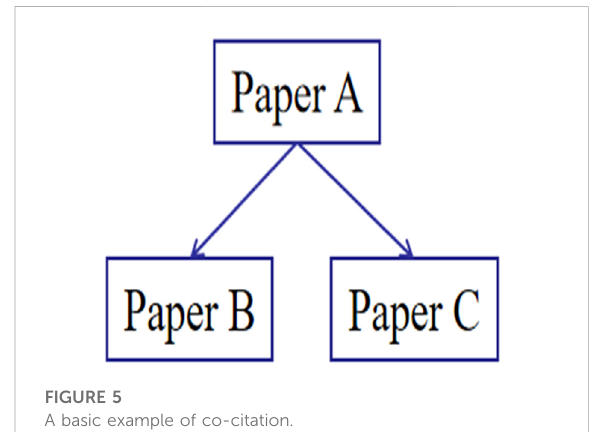
FIGURE 5 A basic example of co-citation.